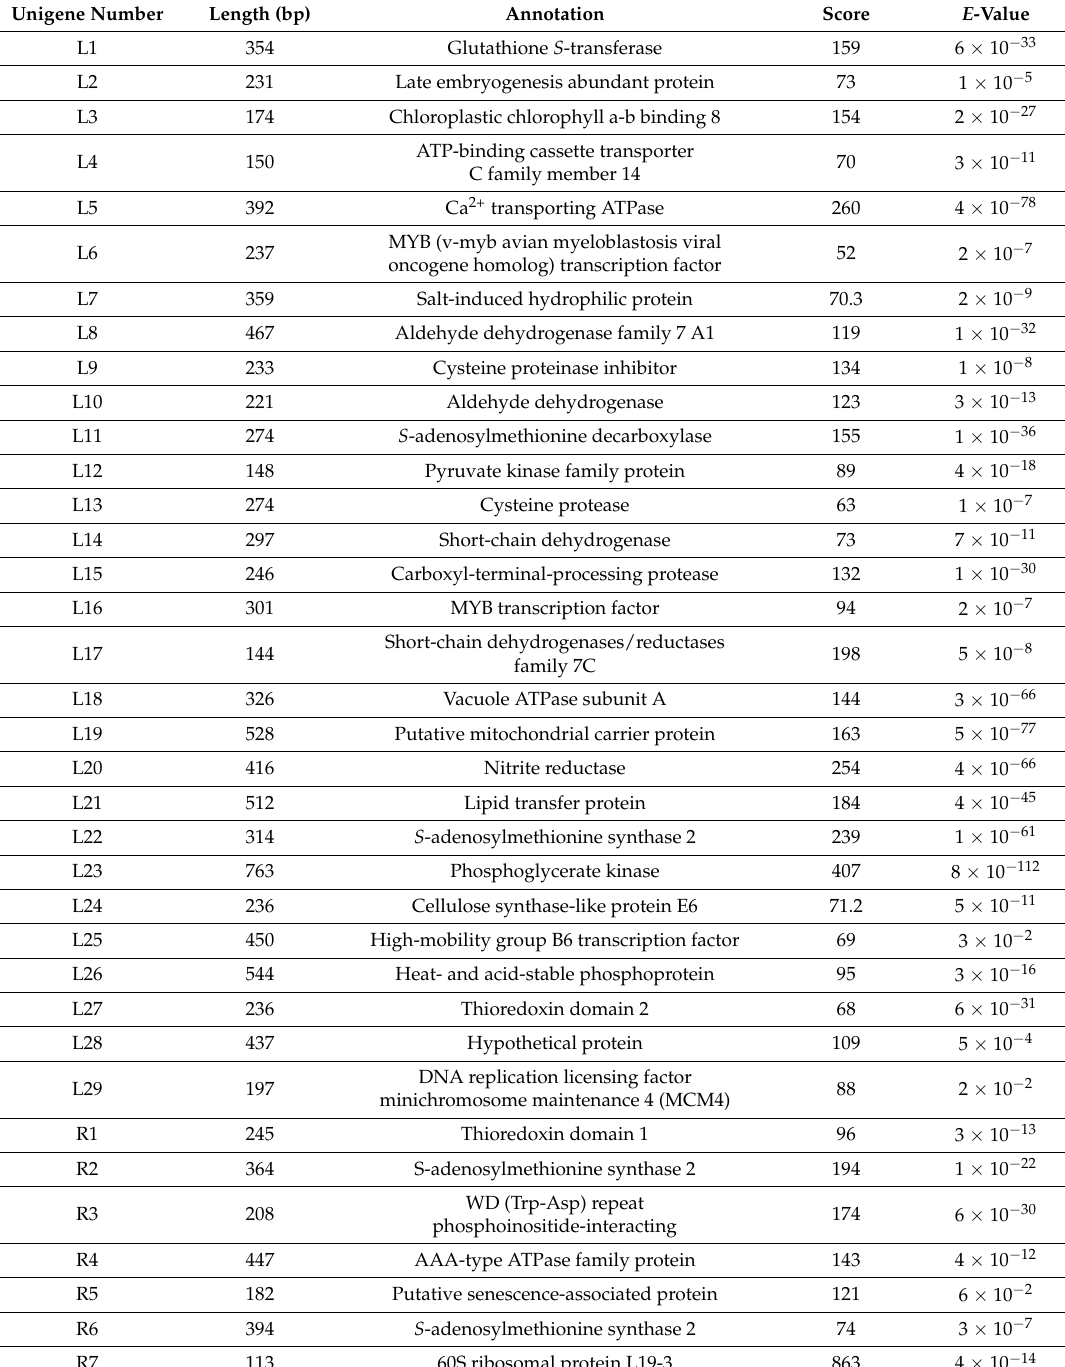
Table 1. cDNA clones isolated from a subtractive hybridization library of salt stressed sugar beet M14 roots (R) and leaves